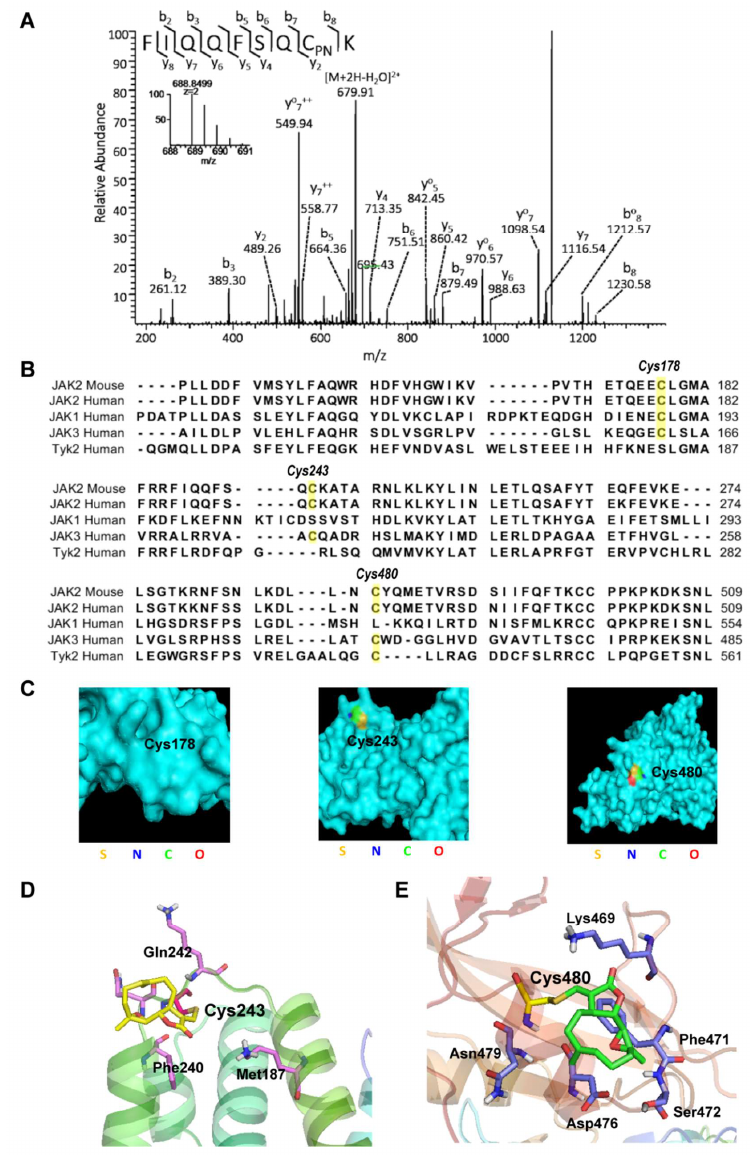
Figure 3. LC-MS/MS and virtual docking analysis of parthenolide-treated JAK2 protein. ( A ) Cys243 of JAK2 was covalently modified by PN. JAK2-overexpressed HEK 293 cells were incubated with 20 μmol/L PN for 1 h. After that, JAK2 protein was immunoprecipitated and subjected to LC-MS/MS analysis. ( B ) Protein sequence alignment of JAK family members. This work was done by the CLC Main Workbench 6.9.1 software package. ( C ) The positions of Cys178, Cys243, and Cys480 on JAK2 protein. The crystal structure of JAK2 (4Z32) was from RCSB and generated by Pymol. Cysteines were colored. ( D ) The